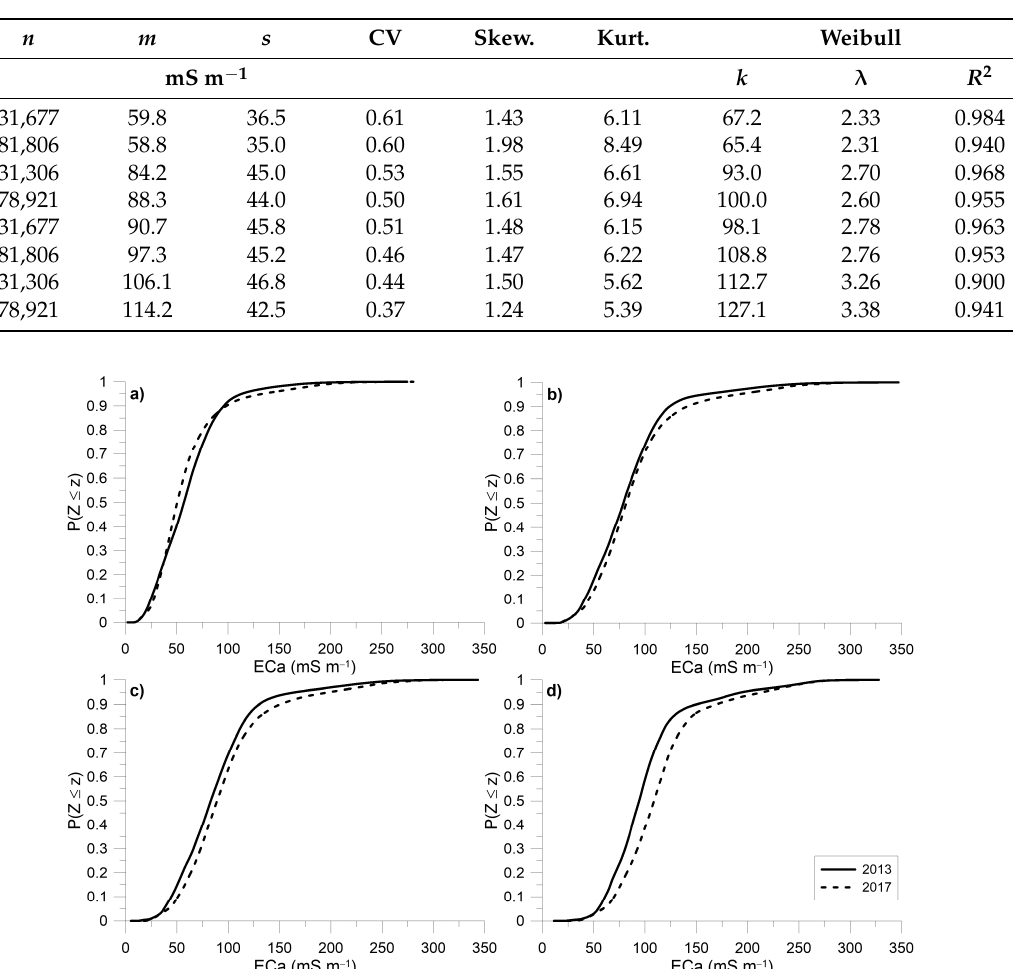
Table 1. Descriptive statistics of the four ECa signals measured in 2013 and 2017. DOE: depth of exploration, n : number of measurements, m : mean, s : standard deviation, CV: coefficient of variation, k and λ : fitted Weibull scale and shape parameters, respectively.